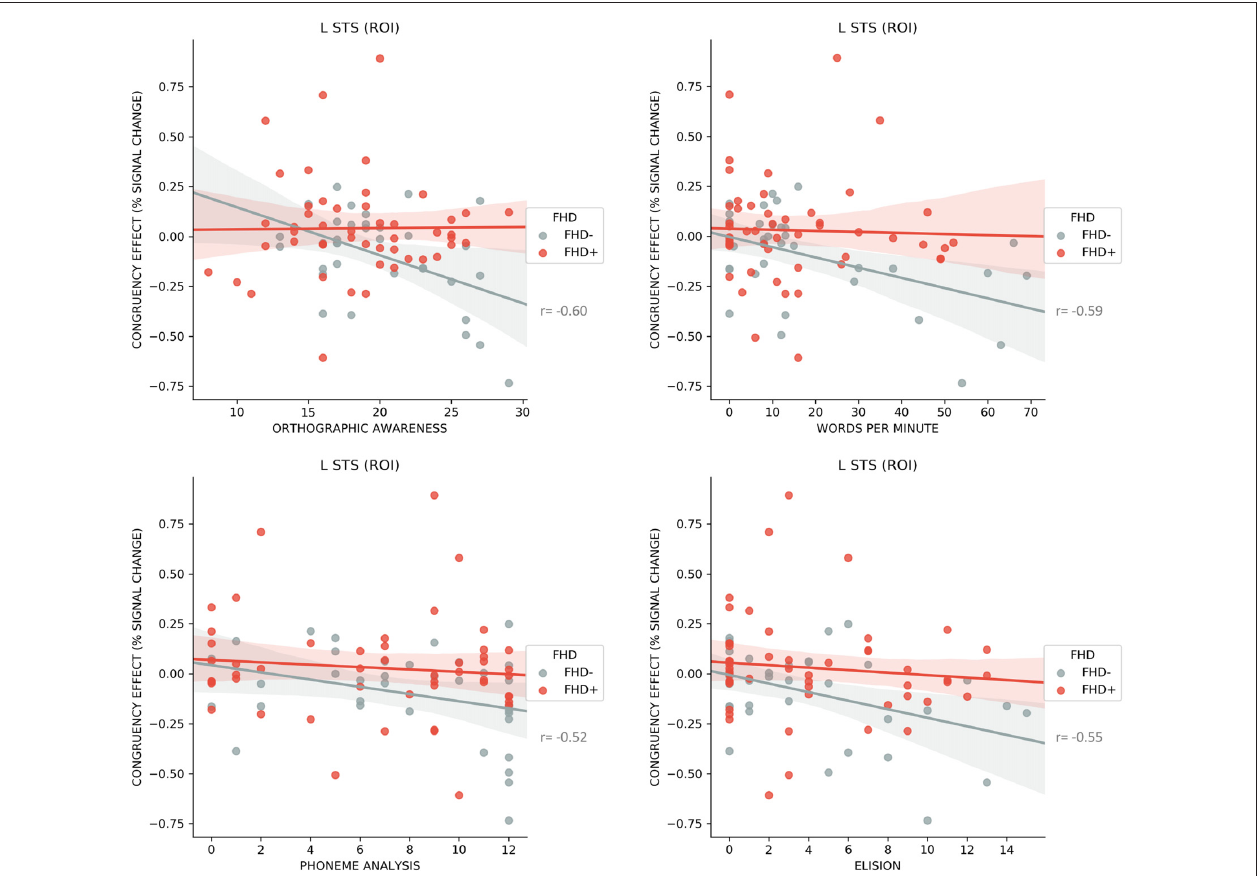
FIGURE 5 | Correlations for FHD − and FHD+ children between the neural response to congruent vs. incongruent letter speech sound pairs (fMRI congruency effect) in left superior temporal sulcus (STS) and orthographic awareness, word reading, phoneme analysis and elision along with 95% confidence intervals. Correlations are significant only in FHD −